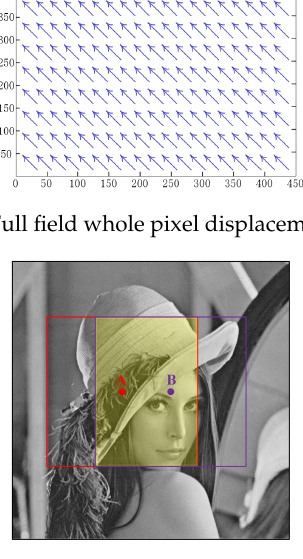
Figure 5. Overlapping regions of adjacent matching